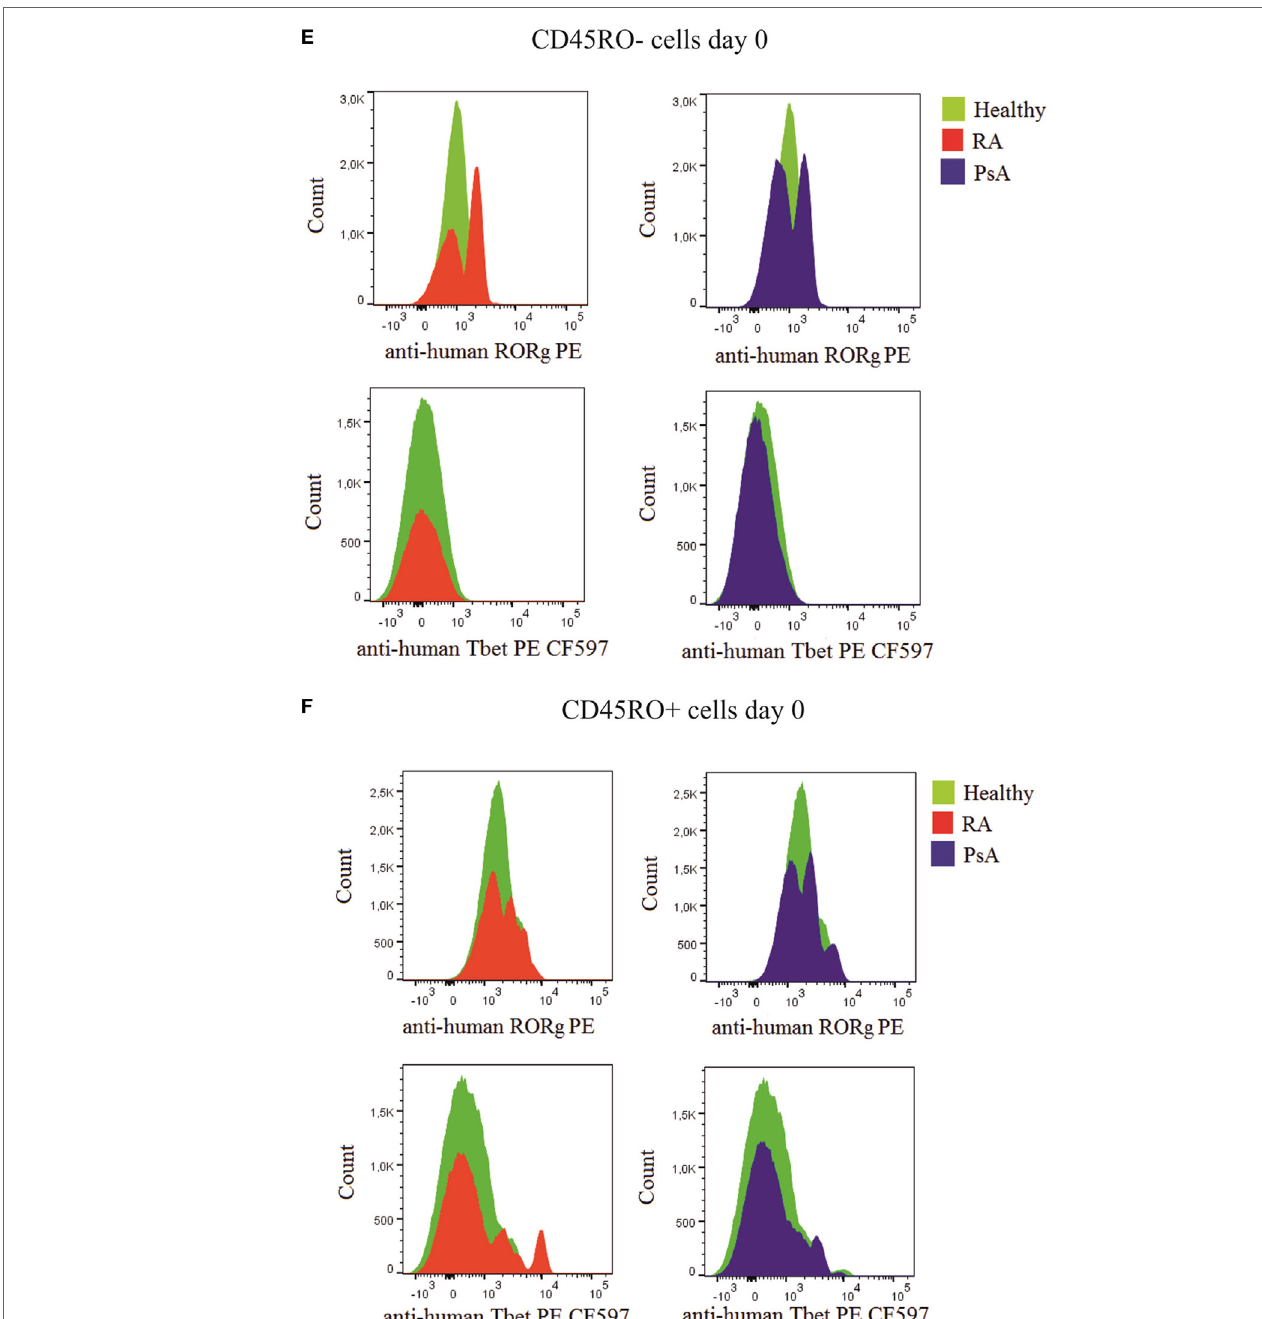
FigUre 2 | RORC and TBX21 expression across patient and healthy donor groups. Messenger ribonucleic acid (mRNA) expressions of RORC and TBX21 in naive (a,B) and memory (c,D) T cells. Gene expressions were measured by quantitative real-time PCR; the values are shown in a logarithmic scale; median, minimum, and maximum of the relative gene expression levels are indicated (Mann–Whitney test ** p < 0.01). Flow cytometry was used to study the RAR-related orphan receptor gamma (ROR γ ) and T cell-specific T-box transcription factor T-bet (T-bet) protein levels of individual cells from healthy donors ( n = 5), rheumatoid arthritis (RA) ( n = 5), and psoriatic arthritis (PsA) ( n = 5) patients. Cumulative histograms of the naive (e) and memory (F) T lymphocytes are shown.